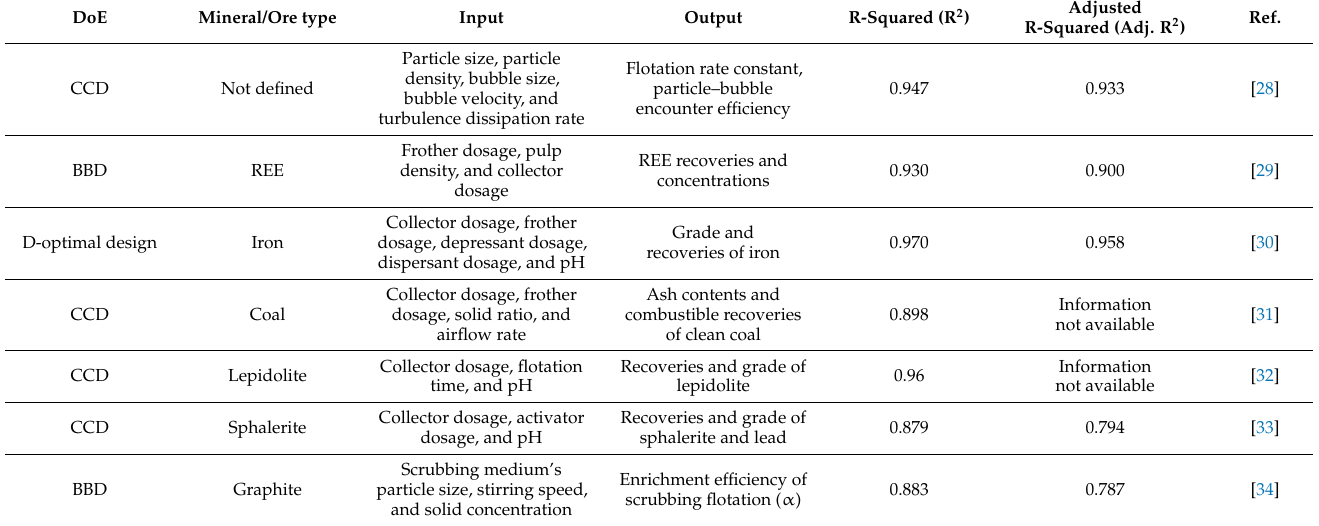
Table 1. Examples of papers on RSM in mineral flotation are available from Web of Science